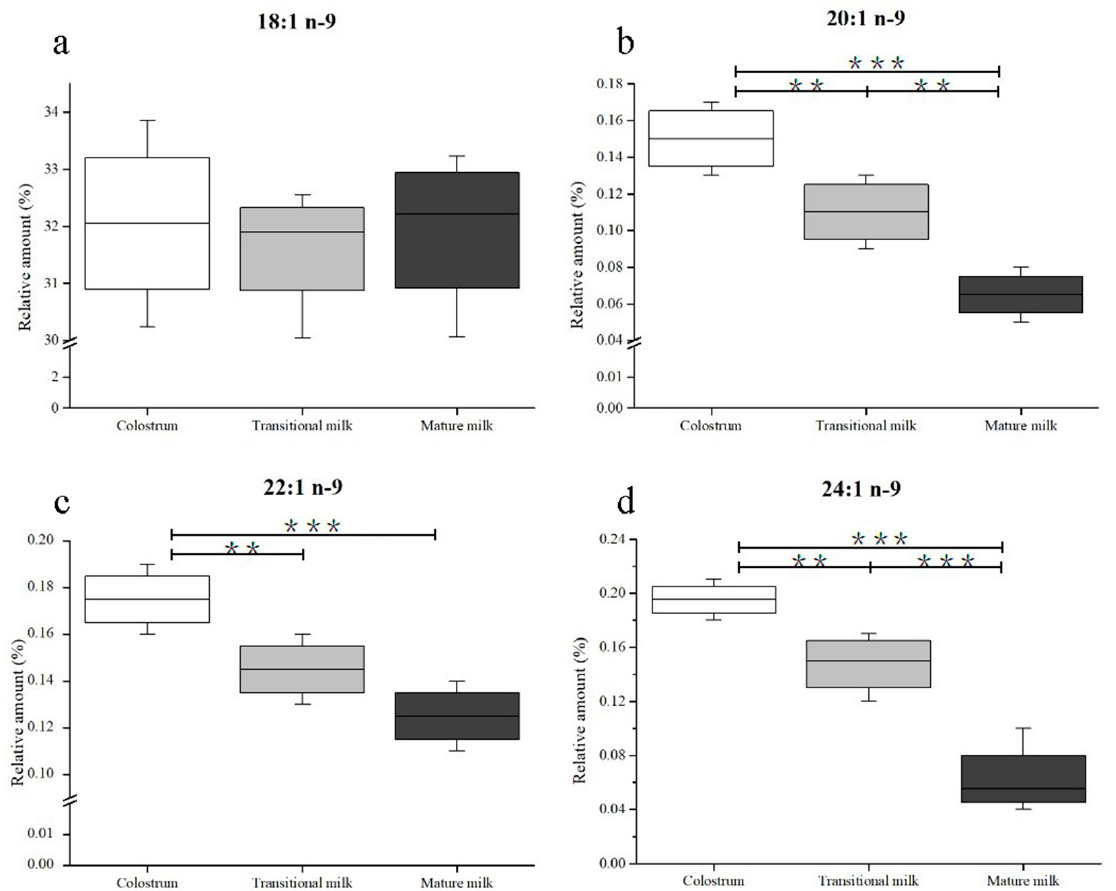
Figure 3. Changes in n-9 fatty acids including 18:1 n-9 ( a ), 20:1 n-9 ( b ), 22:1 n-9 ( c ), and 24:1 n-9 ( d ) in human milk during the first month of lactation. Significantly different from colostrum, transitional milk, and mature milk: *** p < 0.001; ** p < 0.01. No labeling indicates no significant differences.